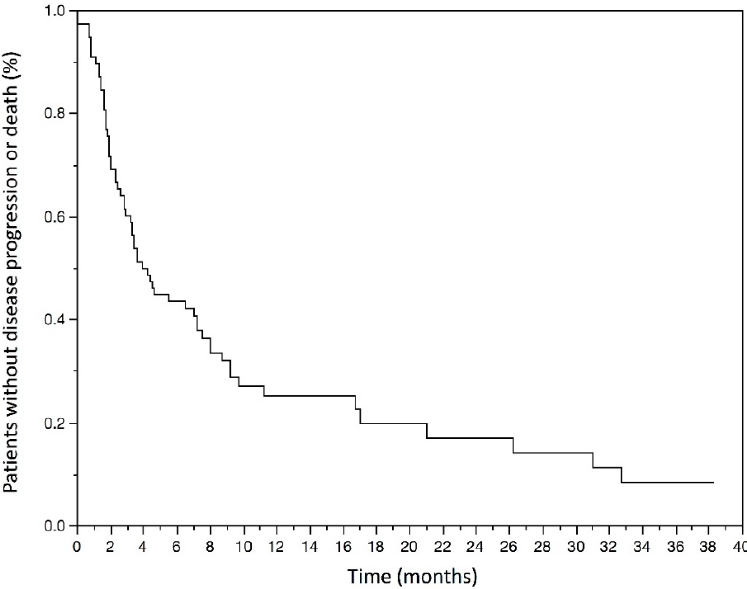
Figure 2. Kaplan–Meyer estimates of Progression-free survival in months in the studied population. Table 2. PFS status at 6 months—Multivariate analysis.